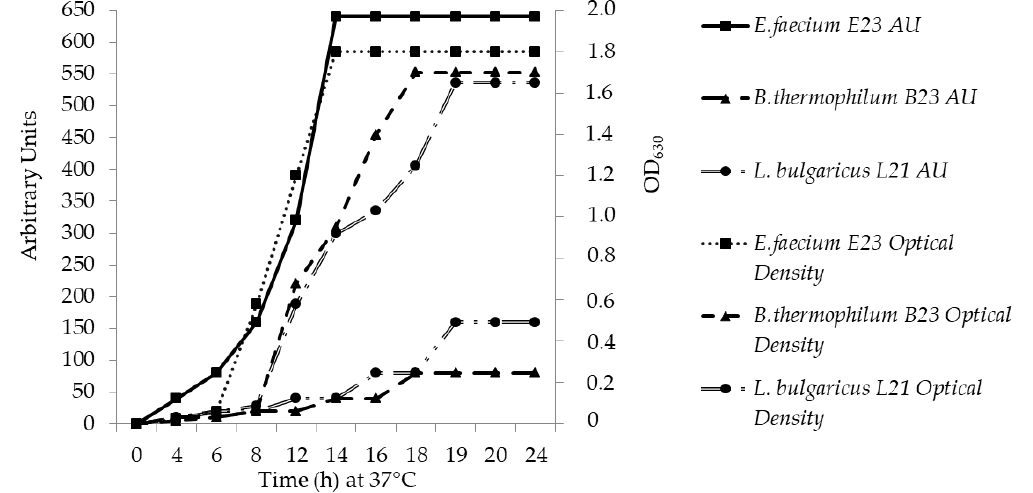
Figure 1. Production of enterocin E23, thermophilicin B23 and lacticin L21 at 37 °C. At appropriate time intervals, samples were taken and the bacterials growth (OD 630 ) and bacteriocin activity (AU / mL) were determined.